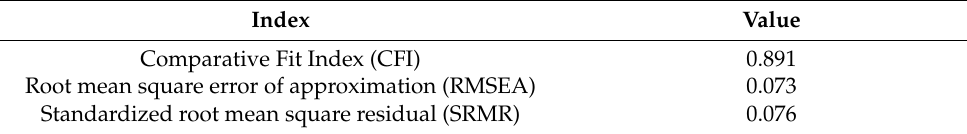
Table 6. Fit indices—CFA across grades of school.